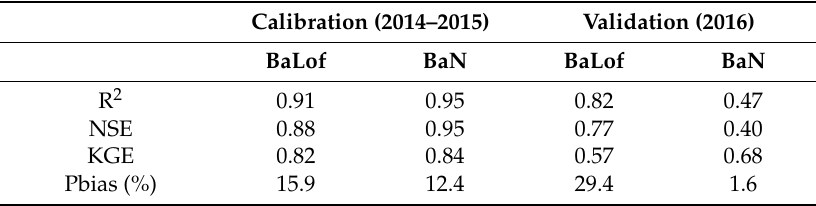
Table 3. Model performance for daily simulated values for the upstream area Bankandi-north (BaN) and the outlet of the Bankandi-Lo ffi ng (BaLof)